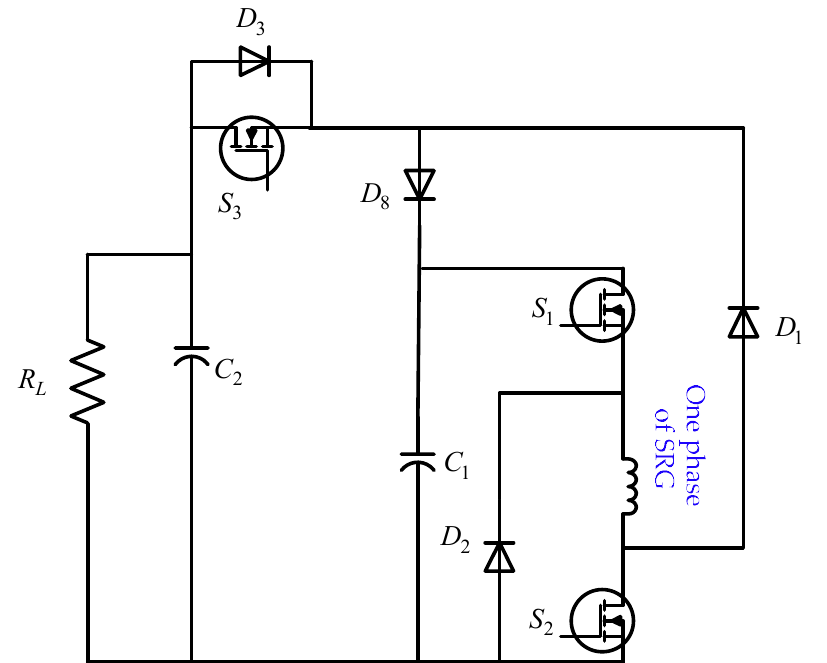
Figure 11. Active boost power converter.